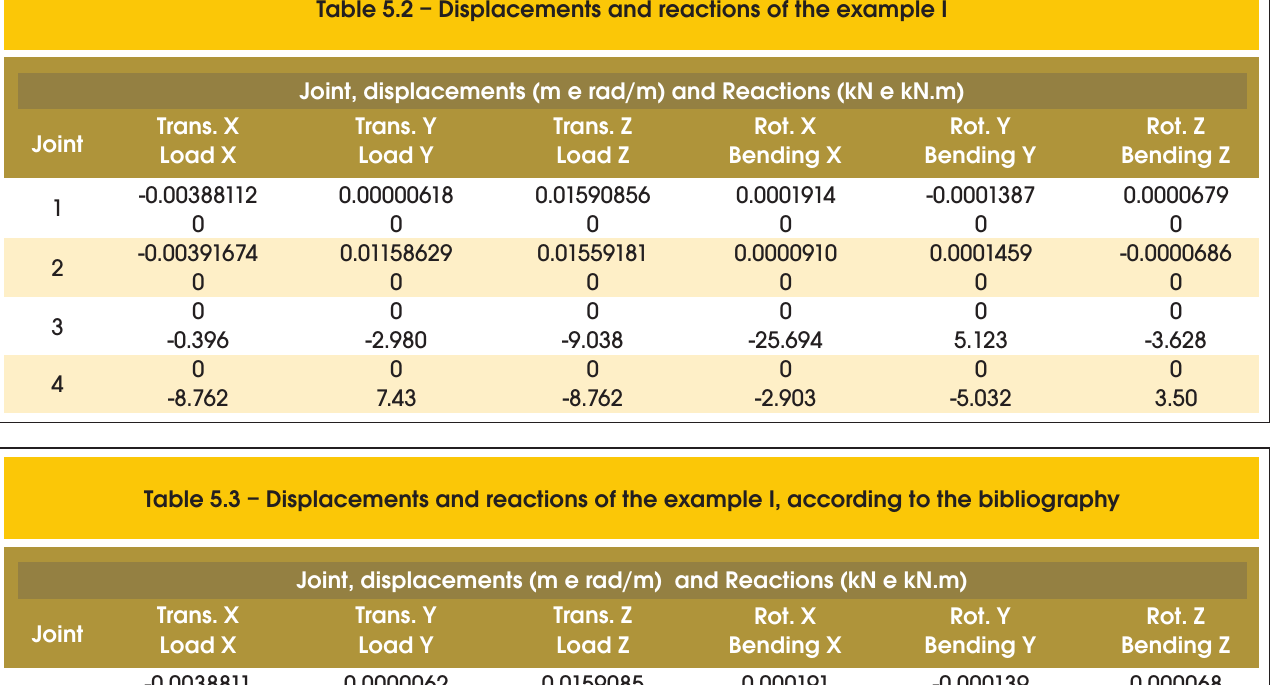
Table 5.2 – Displacements and reactions of the example I